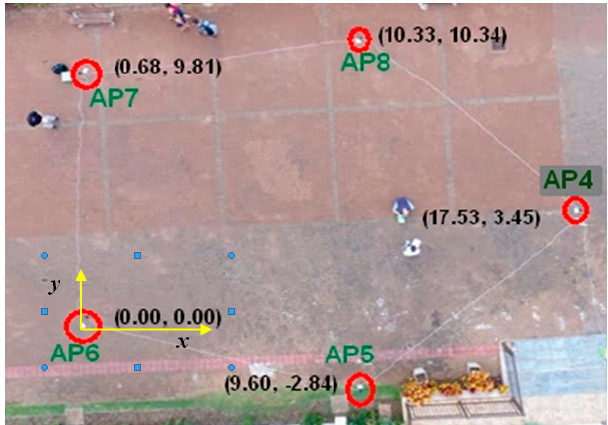
Figure 14. Structure composed of five Access Point (AP) devices and their respective position on an outdoor environment.